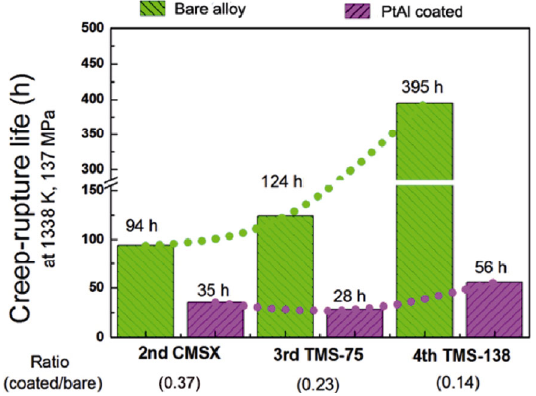
Fig. 44 Creep-rupture life reduction for different SXs covered with PtAl